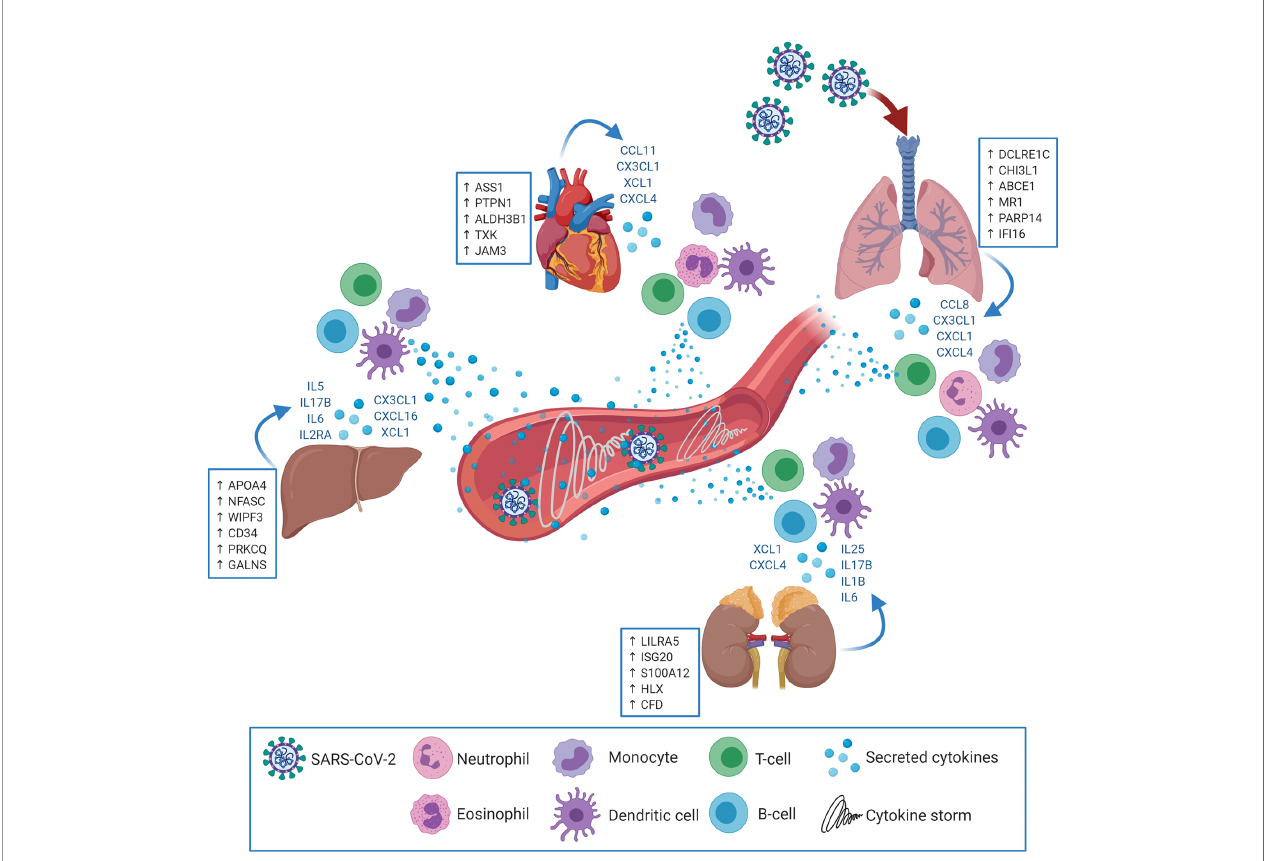
FIGURE 7 | SARS-CoV-2 may target extrapulmonary tissues along pulmonary tissues thereby inducing transcriptional shifts in the expression of central immune regulators (examples in the blue boxes; putative biomarkers unique for each tissue). Consequently, pulmonary as well as extrapulmonary tissues may secrete cytokines and immune mediators (in blue font) resulting in the chemoattraction and activation of innate and adaptive immune cells (e.g. Neutrophils, eosinophils, monocytes, dendritic cells, T-cells and B-cells). Upon activation, the in fi ltrating immune cells begin to uncontrollably secrete additional cytokines and immune mediators which elicits the cytokine storm and system in fl ammation